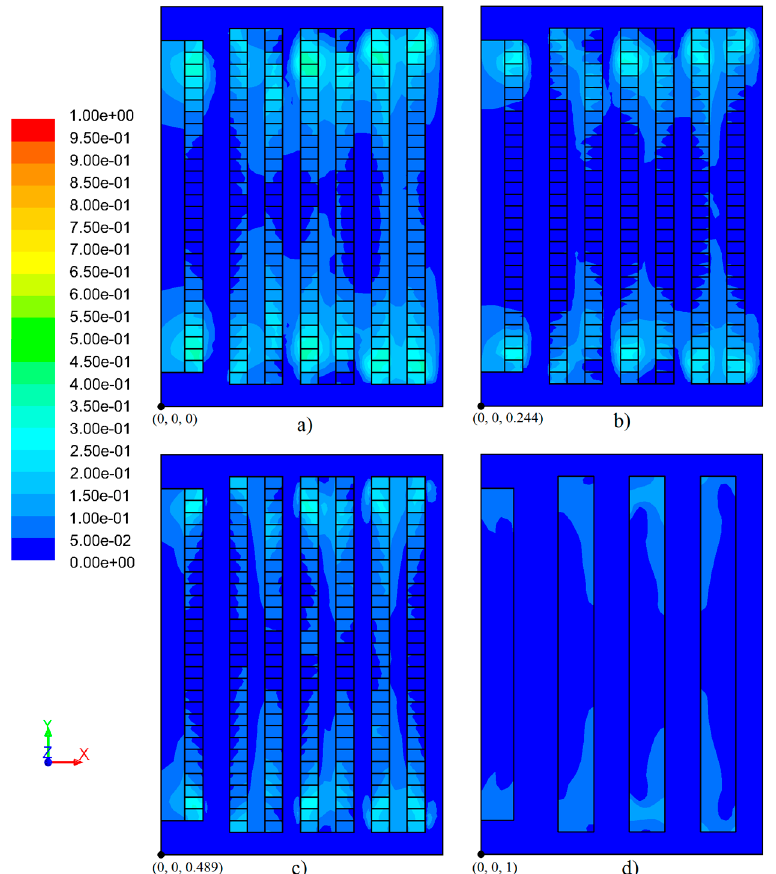
Figure 8. The results of the field of temperature in the x–y plane through planes: ( a ) z adm = 0; ( b ) z adm = 0.244; ( c ) z adm = 0.489; and ( d ) z adm = 1.